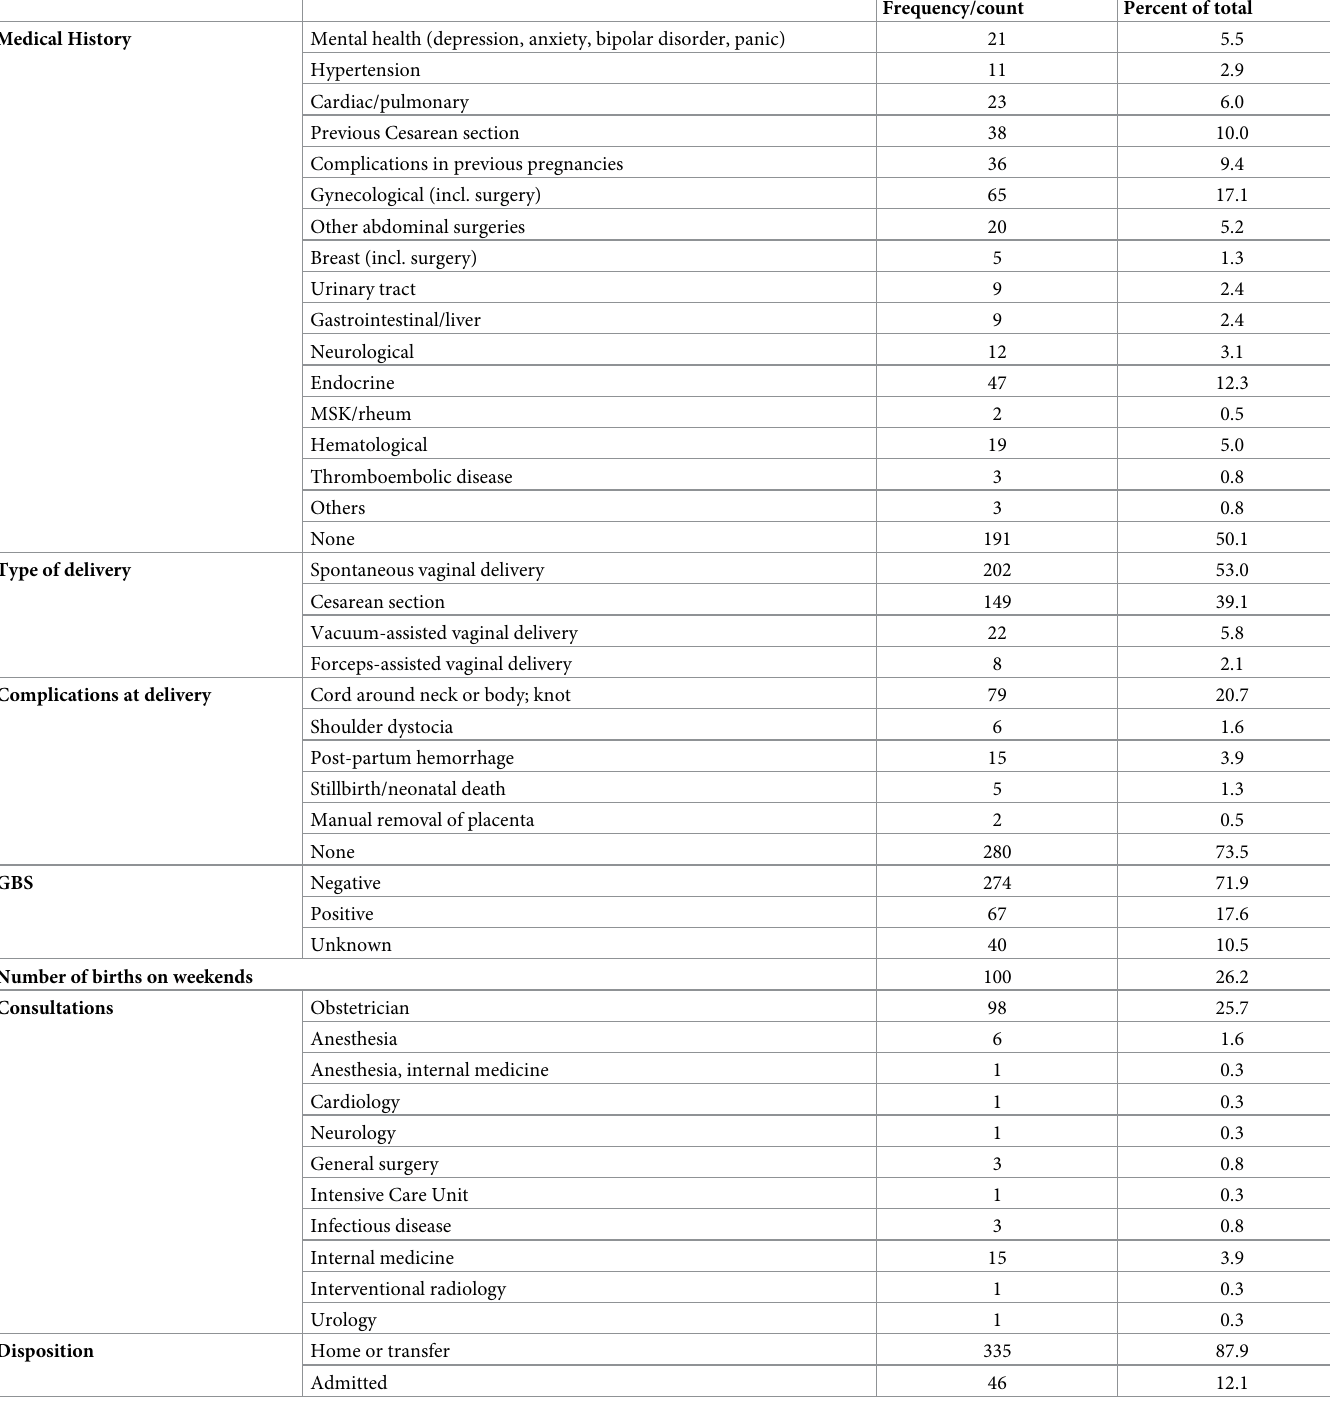
Table 2. Frequency and percentage of key patient